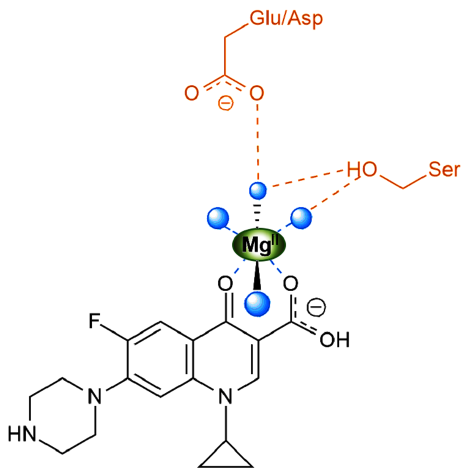
Figure 2. Coordination of Mg 2 + at the binding site of ciprofloxacin to topoisomerase IV in the